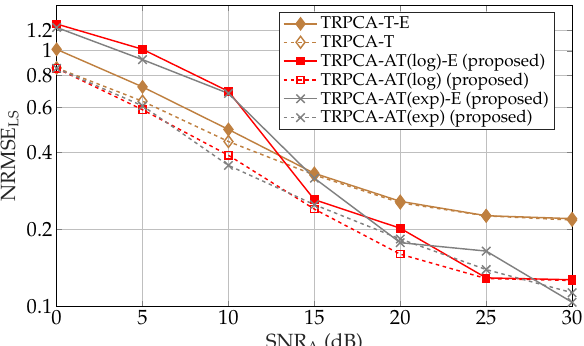
Figure 10. Average combined recovery error of low-rank and sparse matrices for compression ratio K / MN = 25% with different model error levels for ADMM-based trained RPCA with thresholding (TRPCA-T), proposed ADMM-based trained RPCA with adaptive thresholding based on logarithm heuristic (TRPCA-AT(log)), and proposed ADMM-based trained RPCA with adaptive thresholding based on exponential heuristic (TRPCA-AT(exp)). Here, model error means that the training and testing samples are generated with different measurement matrices. For training, y = A vec ( L + S ) + n ; for testing, y = ¯ A vec ( L + S ) + n with ¯ A = A + E . The results with model error are represented by solid lines, whereas dotted lines indicates the results when model error distribution is included in